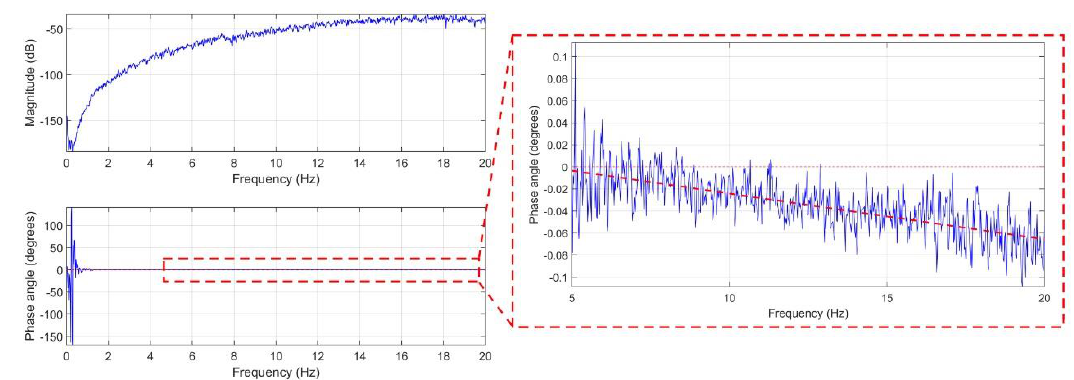
Figure 14. Cross power spectral density (CPSD) and phase diagram for a 15 min duration LBCB test.